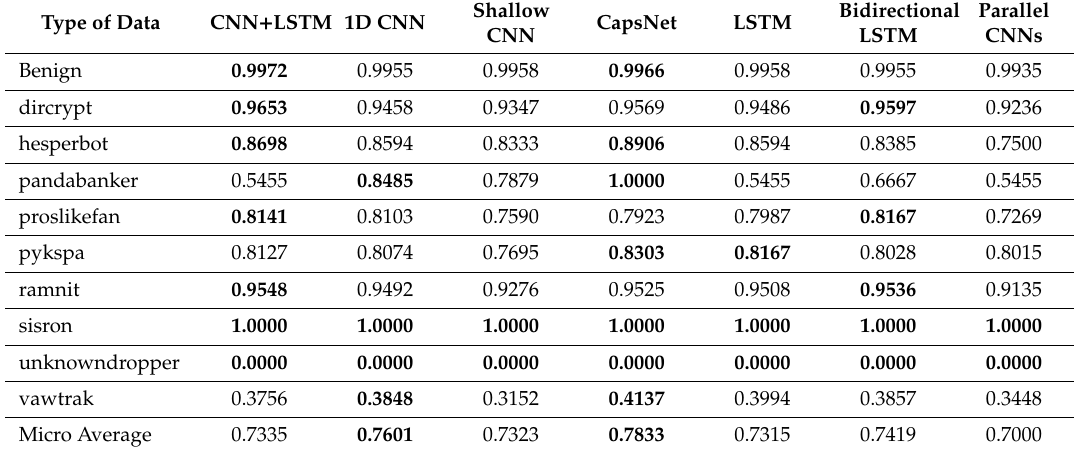
Table 7. Results of novel DGA experiment with the test dataset for benign and DGA